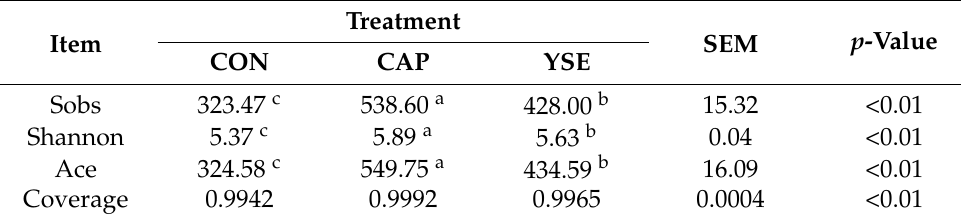
Table 3. Alpha diversity indices of ruminal bacteria in Angus steers fed with different diets.